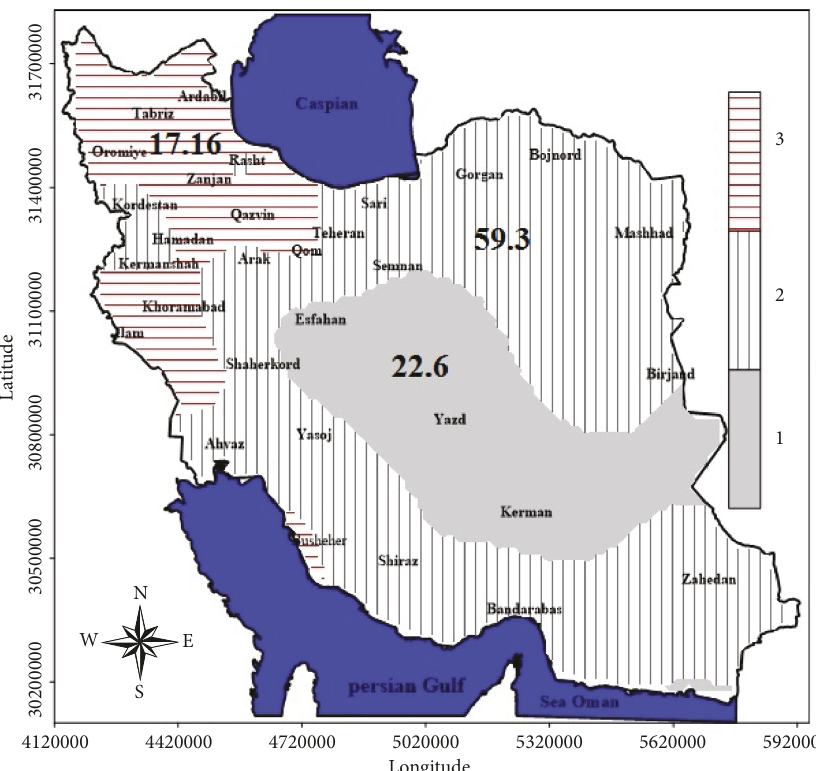
Figure 5: Regions influenced by Iran’s thunderstorms during the past 50 years based on cluster analysis (percent).